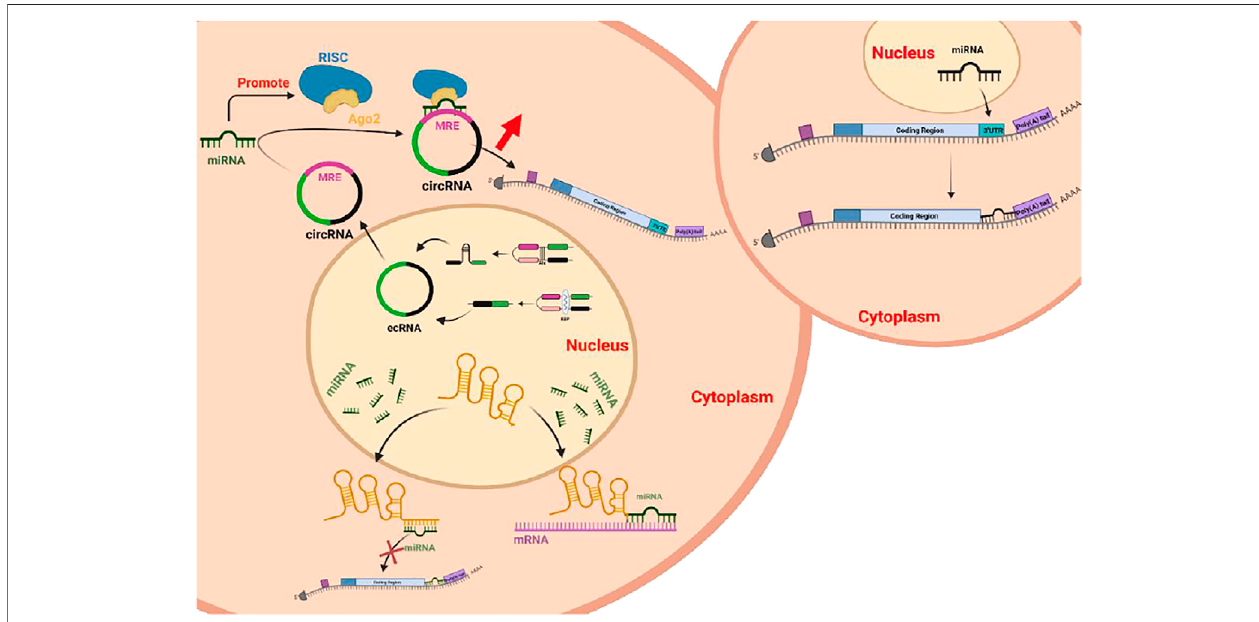
FIGURE 7 | MiRNAs under normal and competing endogenous